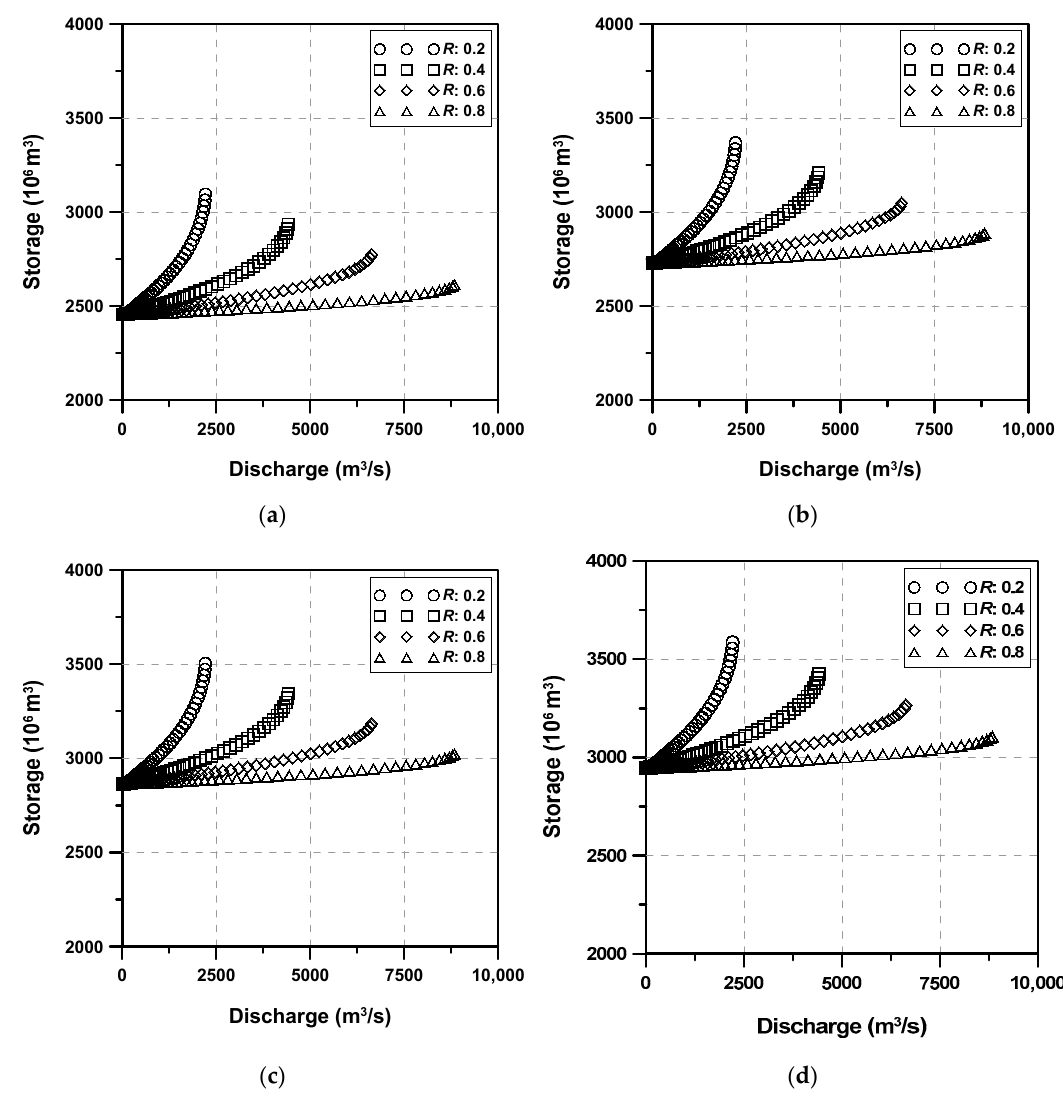
Figure 7. Storage–discharge relations derived with different C/F ratios and constant rates of the Rigid ROM. ( a ) C/F = 3 (RWL: EL. 260.9 m); ( b ) C/F = 5 (RWL: EL. 264.2 m); ( c ) C/F = 7 (RWL: EL. 265.6 m); ( d ) C/F = 9 (RWL: EL. 266.4 m).